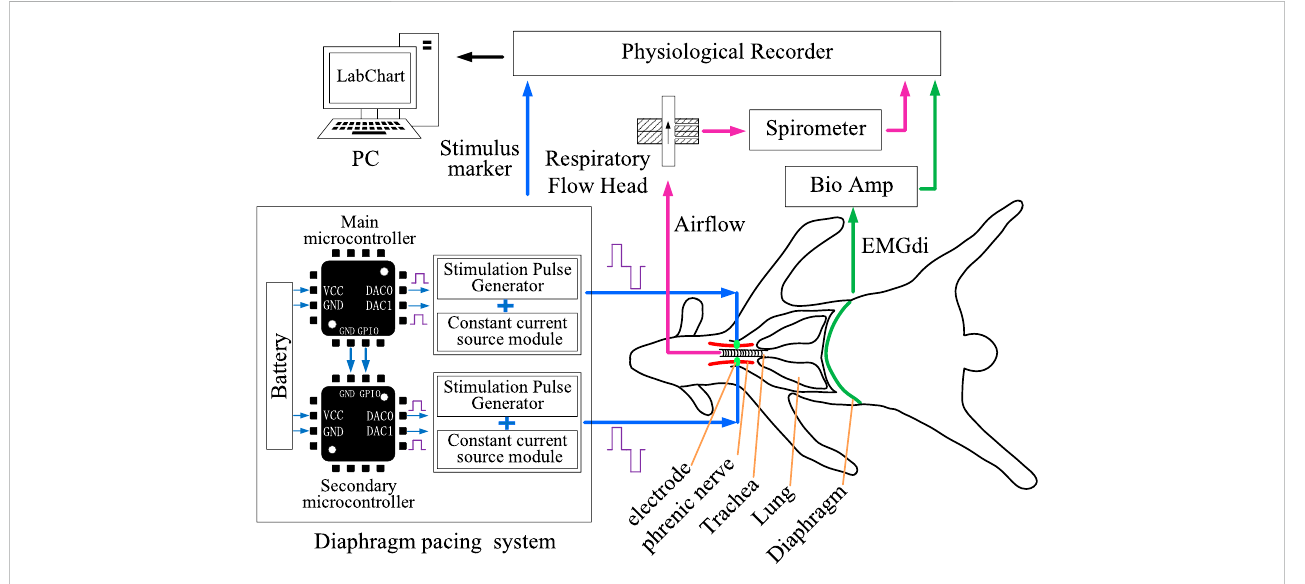
FIGURE 1 Design of DP system and acquisition of physiological parameters. DP system were developed by two microcontrollers. Effects of DP system on respiratory activity were veri fi ed by collecting air fl ow and EMGdi